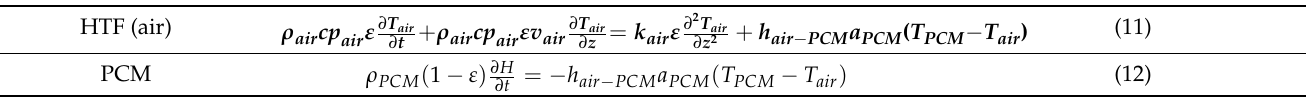
Table 4. 1-D Energy governing equations, which describe the heat exchange between PCM and air, as a function of time and HX length. HTF